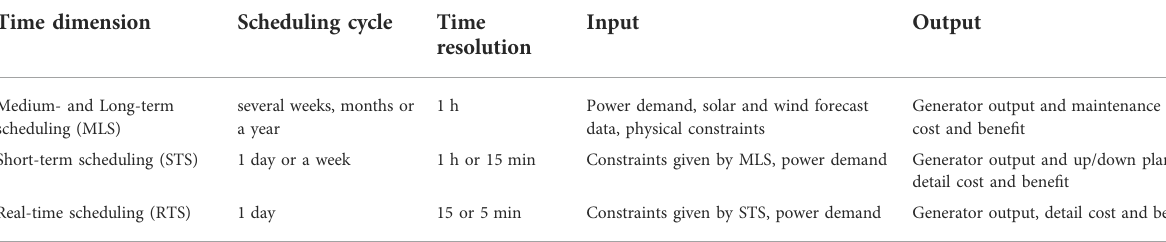
TABLE 1 The difference in three time